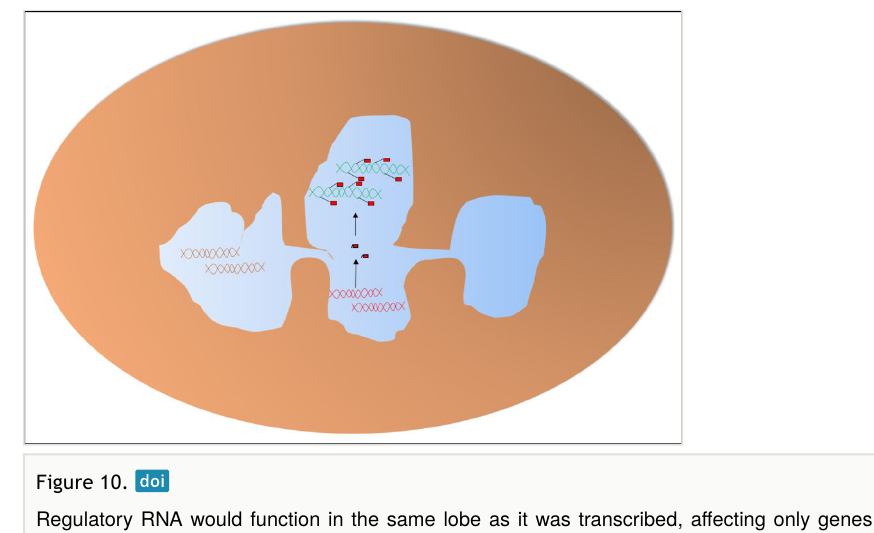
Regulatory RNA would function in the same lobe as it was transcribed, a ff ecting only genes distributed along with its own